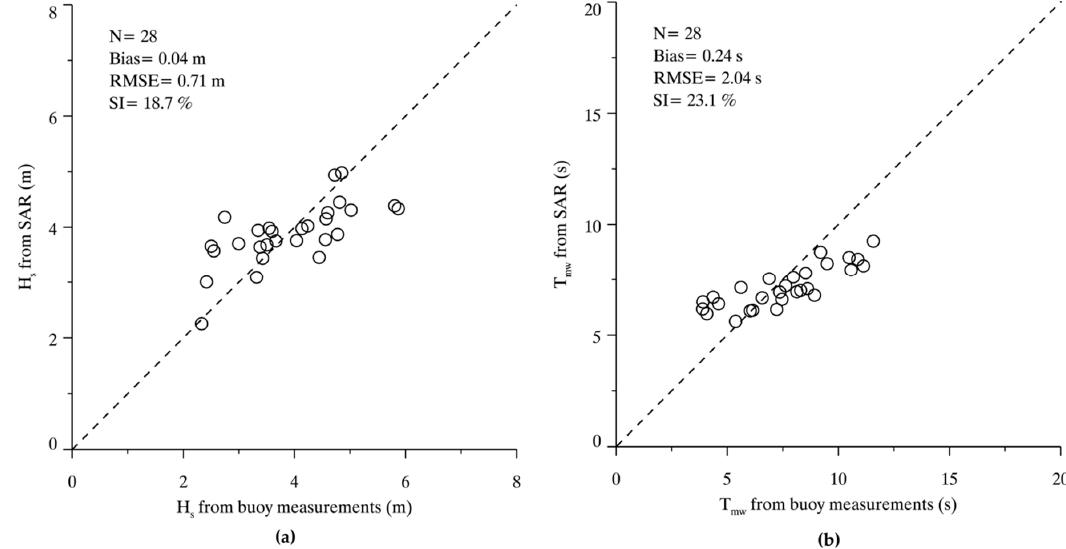
Figure 11. Wave parameters retrieval results from 28 swell-dominant cases are compared to buoy measurements. ( a ) H s comparison; and ( b ) T mw comparison.